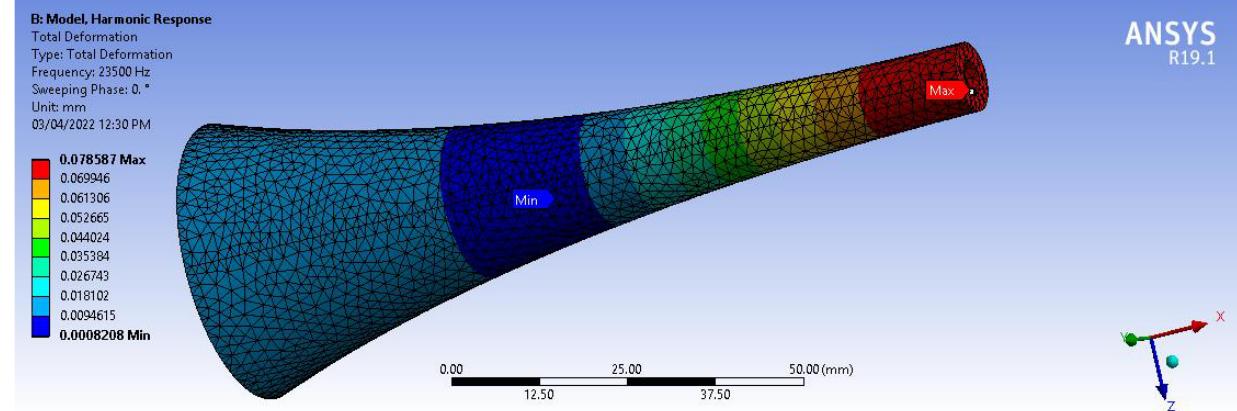
Figure 5. Variation of vibration amplitude along the axial length of aluminium catenoidal horn